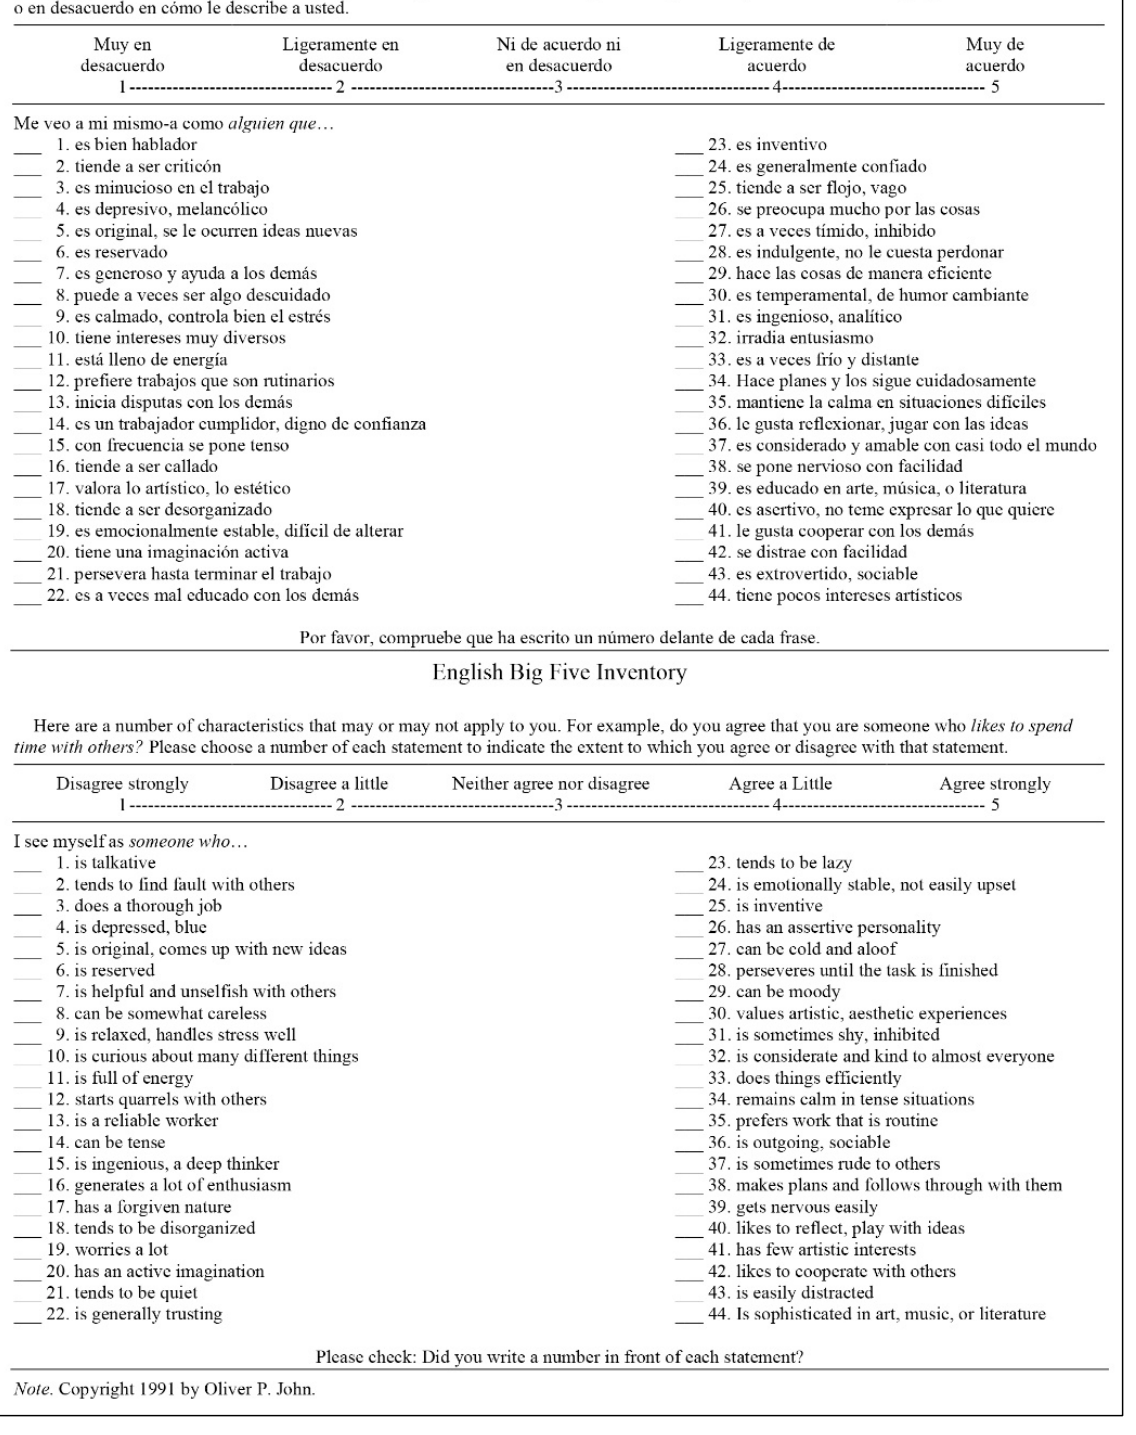
Figure 5. Spanish and English big five inventory.